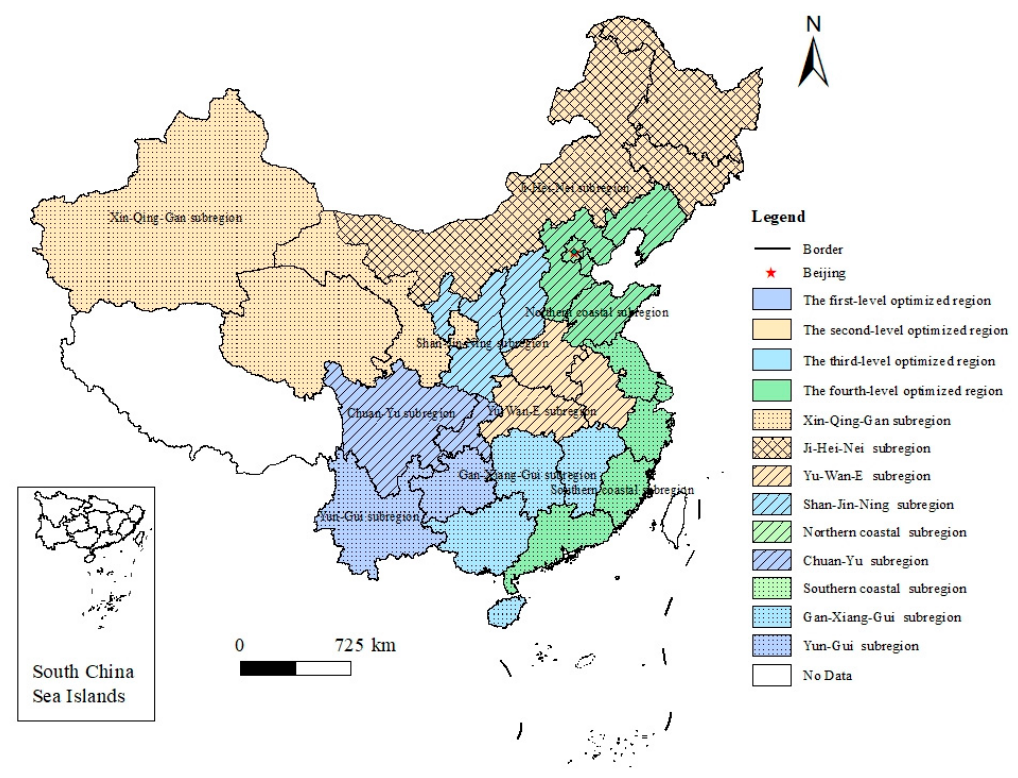
Figure 7. The optimized provincial pattern of rural residential land functions in Figure 7. The o ptimized provincial pattern of rural residential land functions in China.